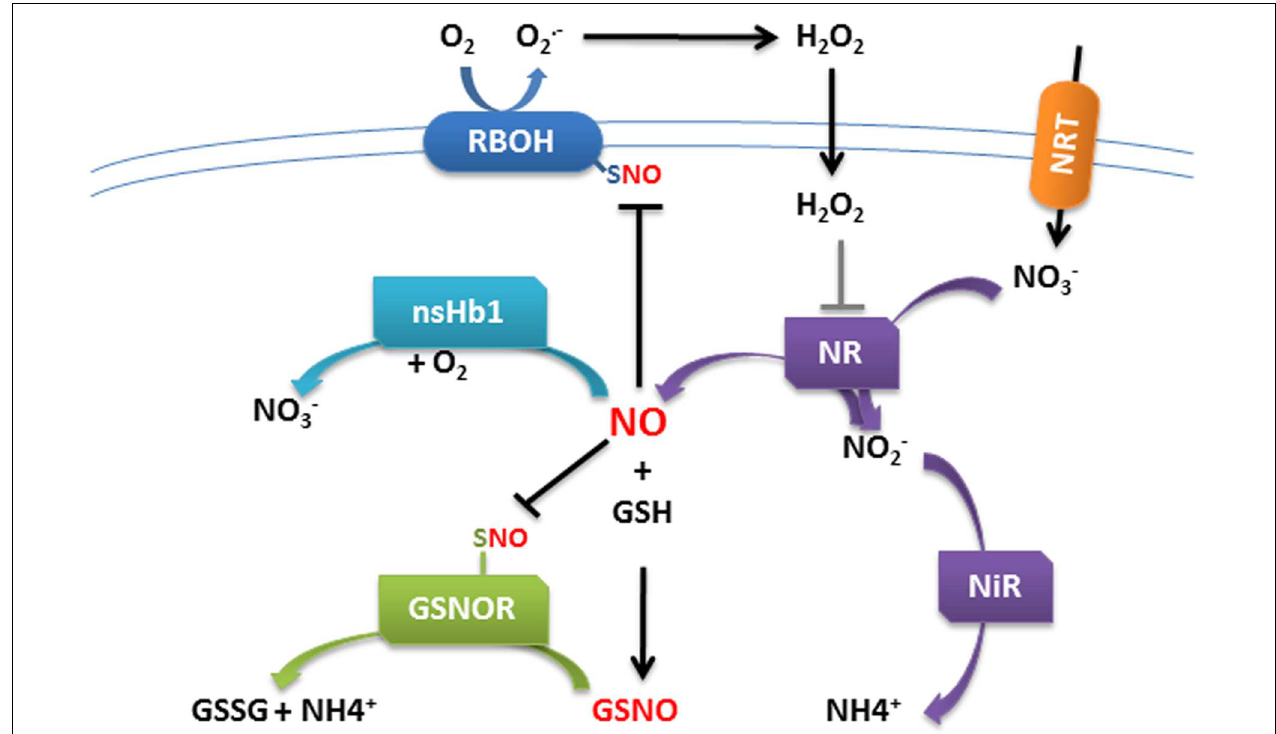
FIGURE 2 | Schematic model of cross-talk regulation between ROS and NO in plant cells. H 2 O 2 produced by NADPH oxidase leads to the activation of nitrate reductase (NR) and concomitant NO production. NO accumulation in turn blunts NADPH oxidase activity by S -nitrosylation, preventing accumulation of excess ROS. In the nitrogen assimilation pathway, nitrate (NO 3 − ) is taken up by nitrate transporters (NRT) and reduced to nitrite (NO 2 − ) by NR. Nitrite is reduced to NO by NR. NO reacts with reduced glutathione (GSH) in the presence of O 2 to form S -nitrosoglutathione (GSNO). GSNO is converted by the enzyme GSNO reductase (GSNOR) into oxidized glutathione (GSSG) and NH 3 . NO accumulation leads to GSNOR S -nitrosylation and inhibition preventing GSNO degradation.